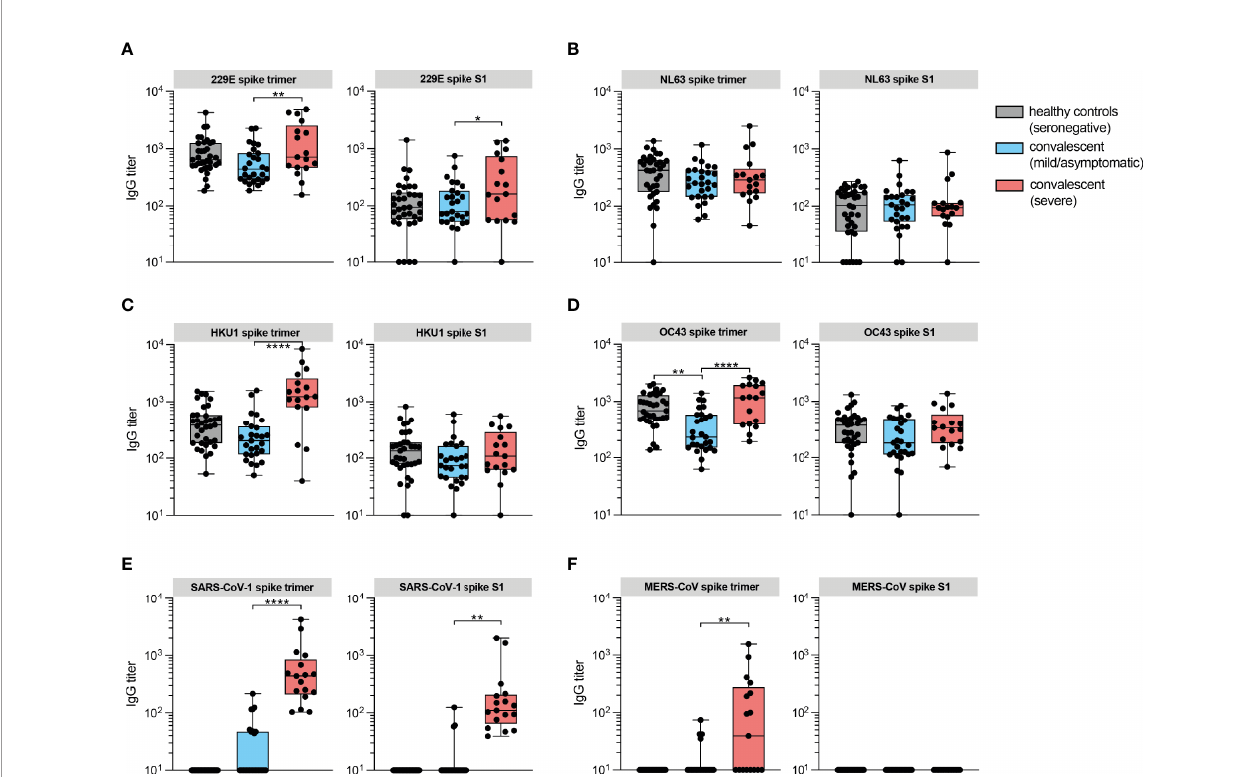
FIGURE 2 | IgG responses against spike protein of eCoVs are induced in convalesced patients with severe COVID-19. (A) IgG antibody titers against recombinant trimeric spike proteins and monomeric S1 subunits of eCoV 229E measured by protein microarray in convalescent sera from COVID-19 patients (red box), mild/ asymptomatic disease controls (blue box) and unexposed healthy controls (gray box). (B) Same as in A for eCoV NL63. (C) Same as in A for eCoV HKU1. (D) Same as in A for eCoV OC43. (E) Same as in A for SARS-CoV-1. (F) Same as in A for MERS-CoV. Data are represented as the median titers (min and max value). Signi fi cance (one-way ANOVA) *P < 0.05, **P < 0.01, ****P ≤